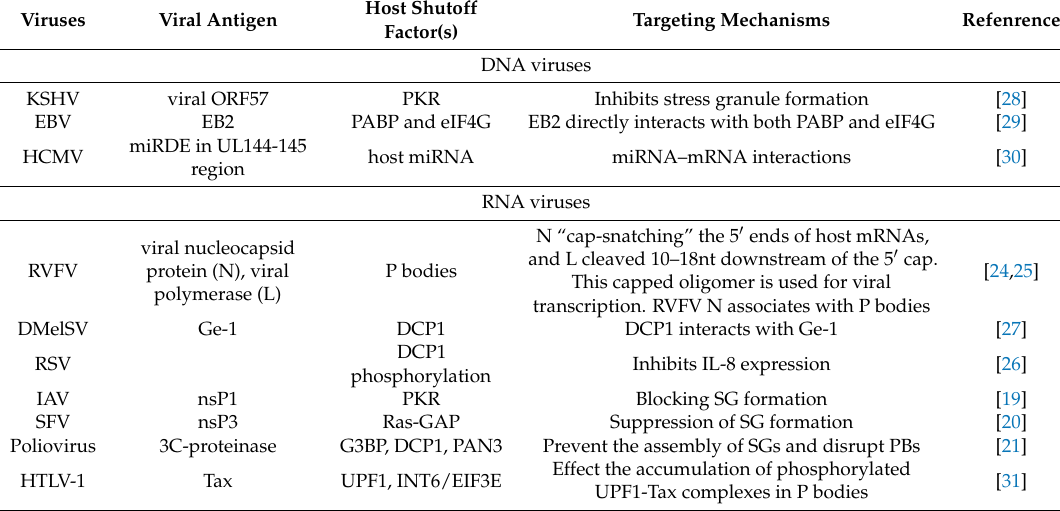
Table 1. Molecular mechanisms of viruses indirectly destabilize cellular mRNAs. KSHV: Kaposi’s sarcoma-associated herpesvirus; EBV: Epstein–Barr virus; HCMV: Human cytomegalovirus; RSV: respiratory syncytialvirus; DMelSV: Drosophila melanogastersigma virus; IAV: influenza A virus; SFV: Semliki Forest virus. HTLV-1: human T- lymphotropic virus type 1; RVFV: Rift Valley